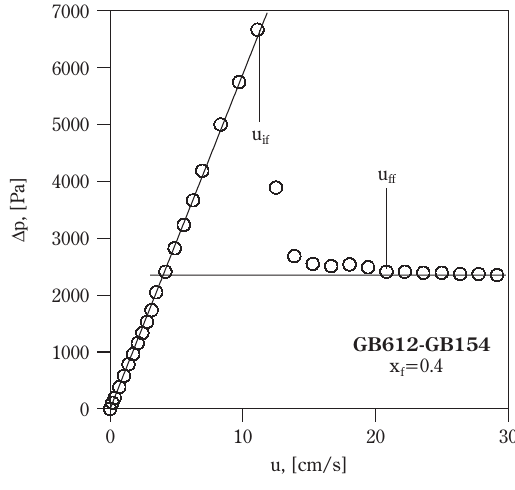
Fig. 6 Pressure drop diagram of a jetsam-on-flotsam segregated binary